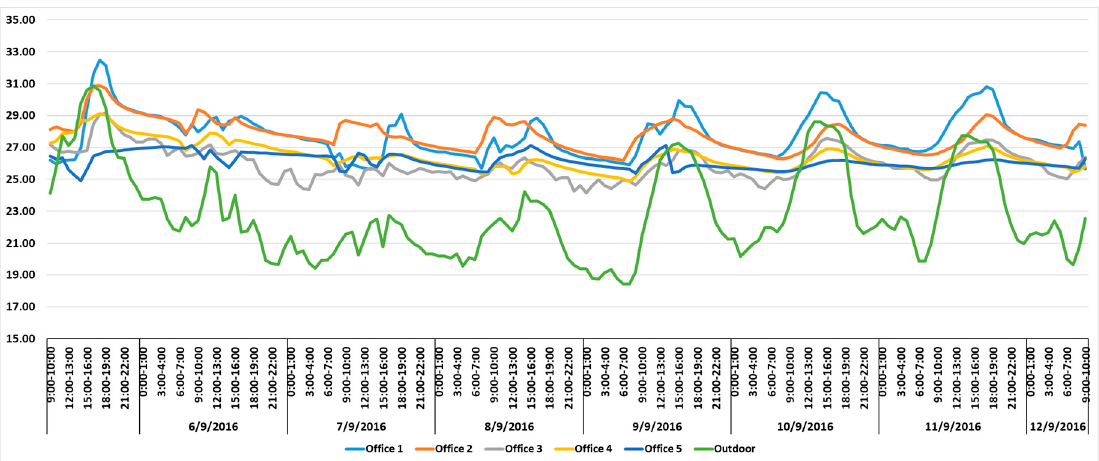
Figure 3. Temperature levels of the external and all the indoor environment of Building A during summer.